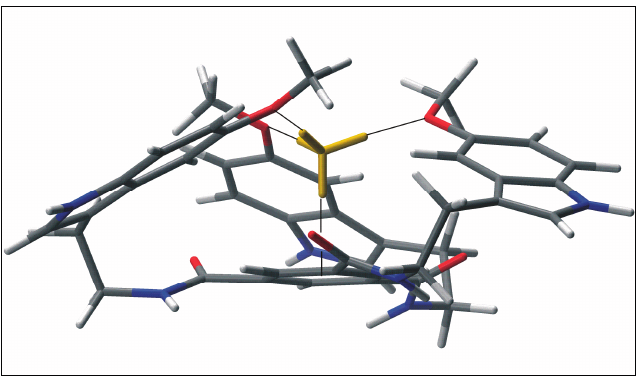
Figure 1. Energy-minimized structure of the 1:1 complex between 3 and NH 4+ (MacroModel V.8.5, OPLS 2001 force field, MCMM, 50000 steps). Color code: receptor N, blue ; O, red; C, gray; NH 4+ is highlighted in yellow